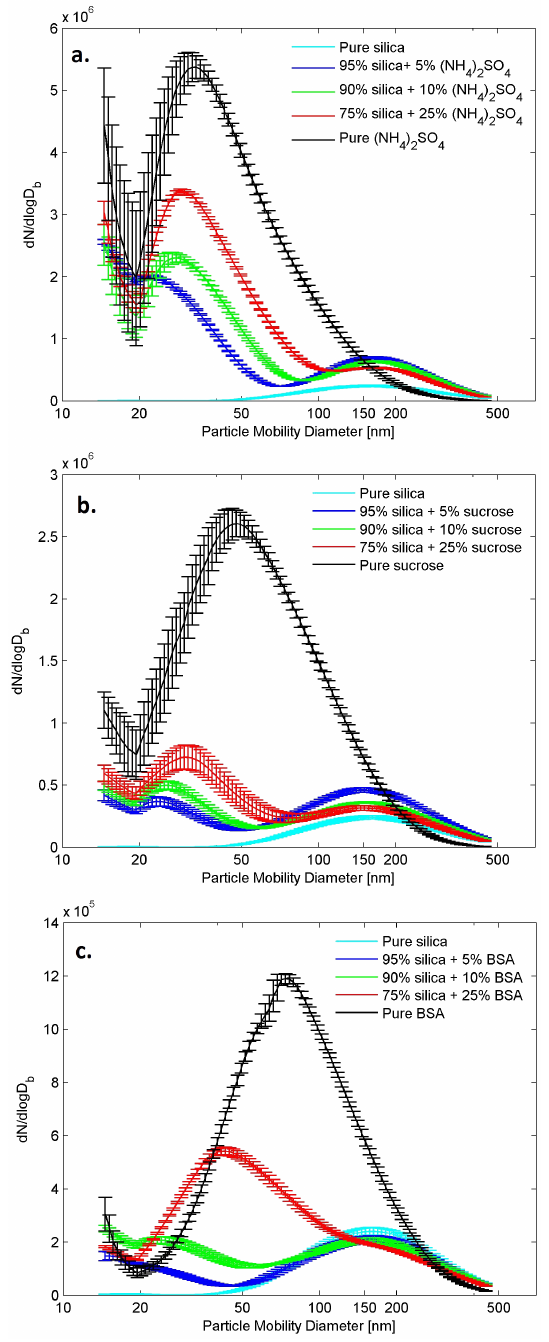
Figure 2. Average particle number size distributions (SMPS) for sil- ica particles mixed with (a) (NH 4 ) 2 SO 4 , (b) sucrose and (c) BSA. Each average size distribution is based on at least 70 individual size distributions, and the error bars represent the standard deviation of the